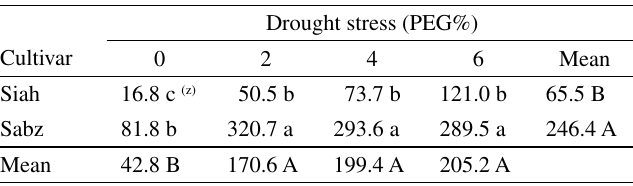
Table 4 - Interaction of water stress and cultivars on leaf proline content